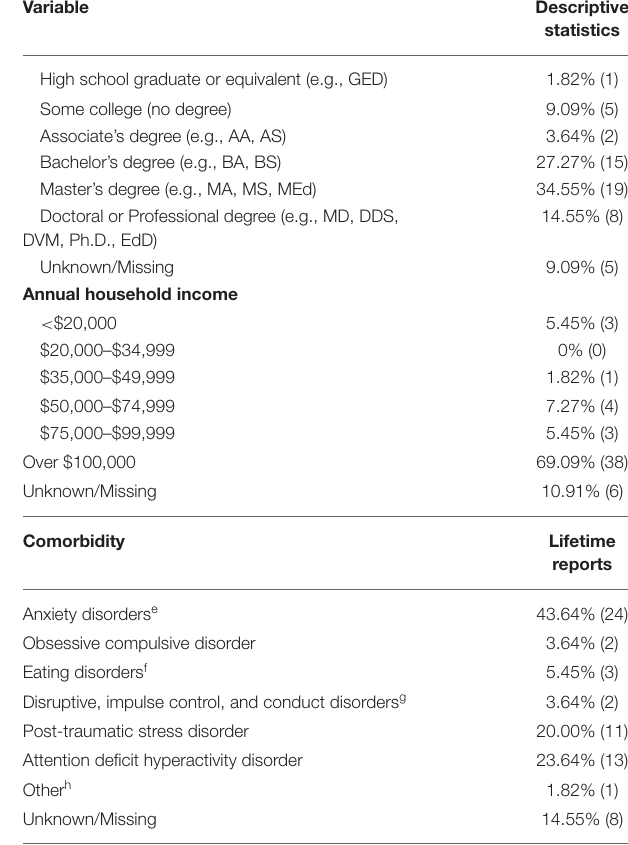
TABLE 1 | Descriptive statistics of participant demographic and clinical